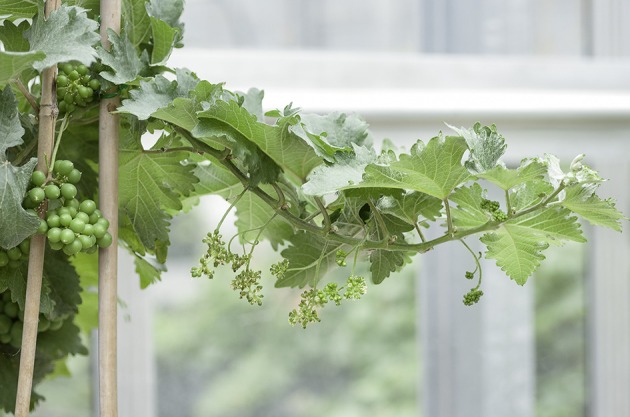
A shoot of microvine 04C023V0006 with flowers and berries at different developmental stages.